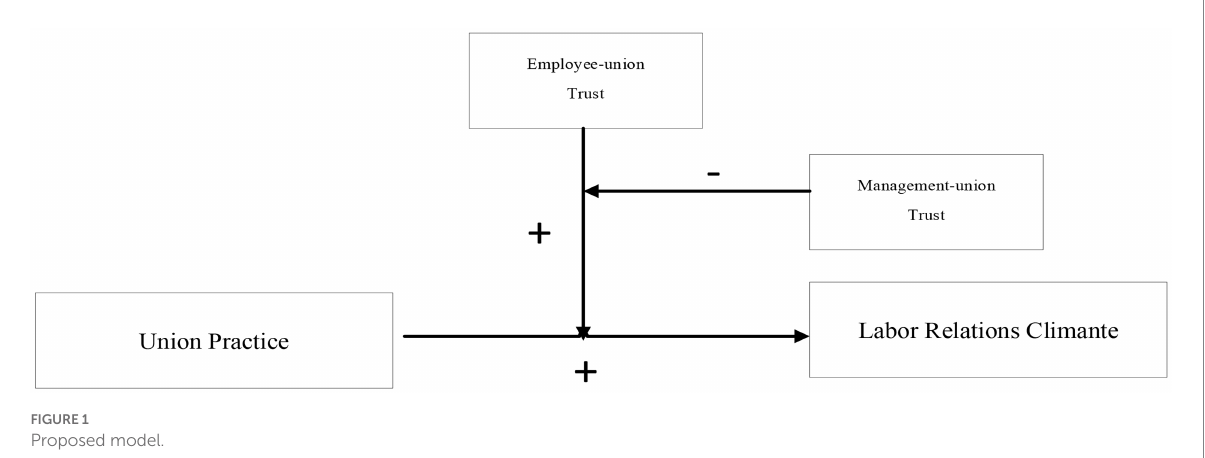
FIGURE 1 Proposed